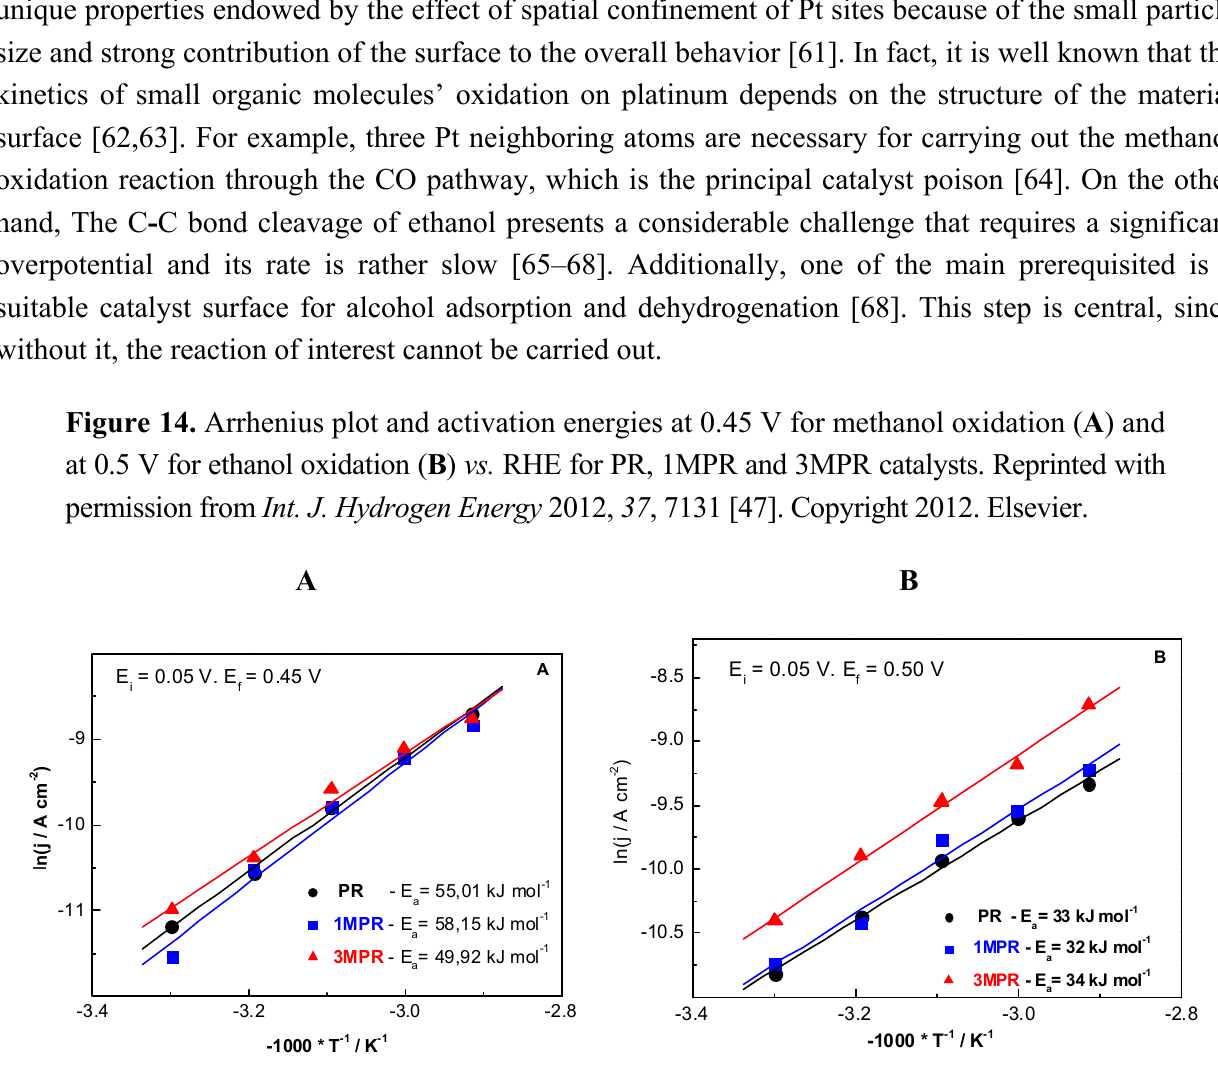
CH OH + 0.5 M H SO . Reprinted 3 2 2 4